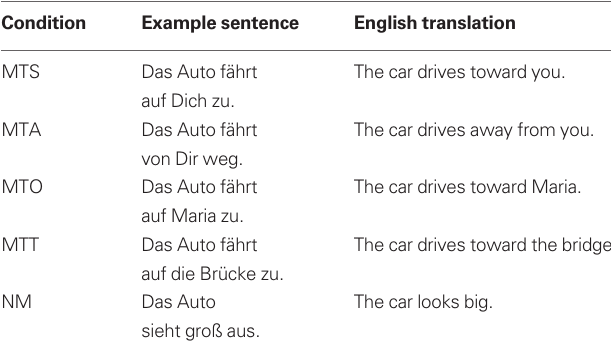
Table 3 | Examples of the sentences used in Experiment 2 with English